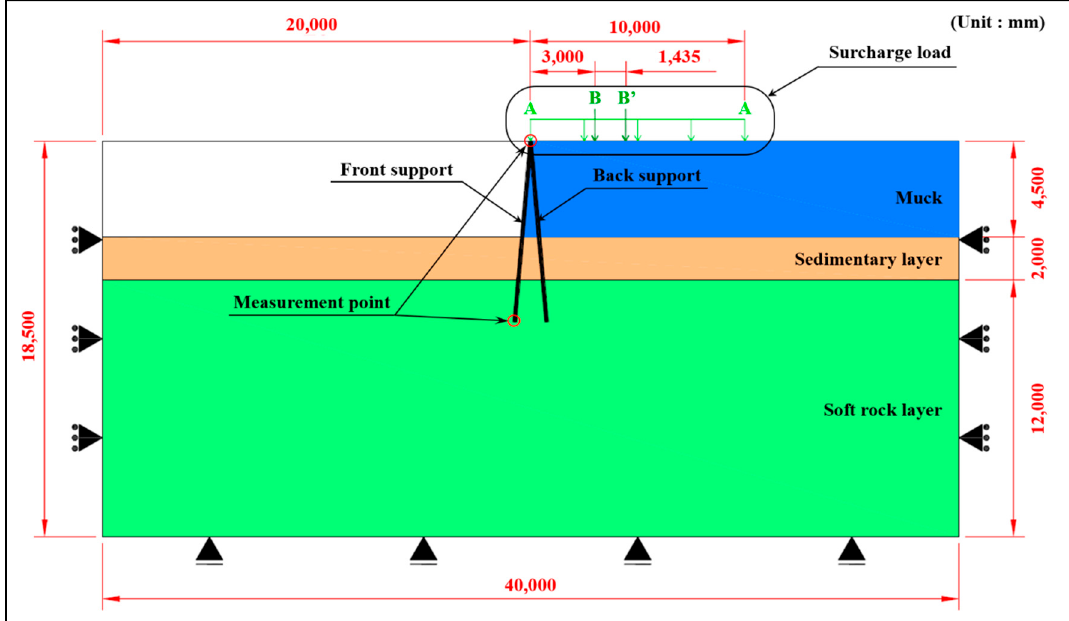
Figure 4. Cross-section for numerical analysis (m).